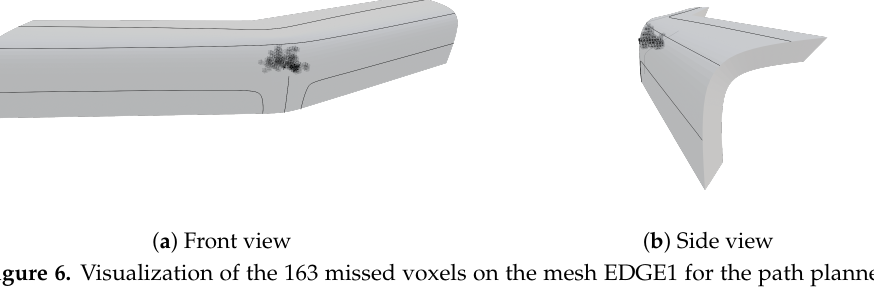
Figure 6. Visualization of the 163 missed voxels on the mesh EDGE1 for the path planned, using papp-base-60